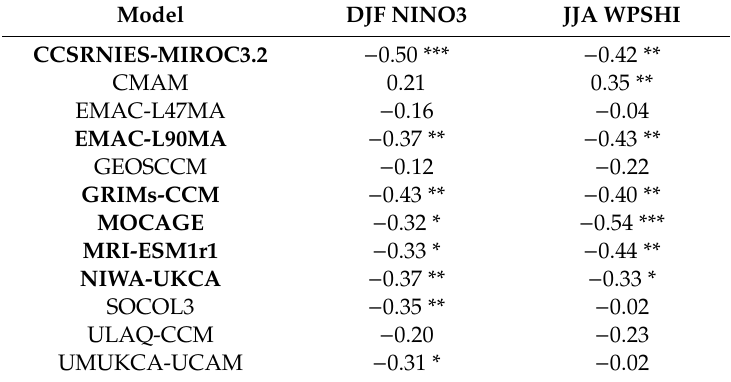
Figure 10. The regressed fields of ( a ) DJF, ( b ) MAM, and ( c ) JJA sea surface temperature (SST) anomalies (shaded; °C) and 850 hPa geopotential height anomalies (contour; m). Black dots indicate statistical significance at the 90% confidence level for SST anomalies based on a Student’s t-test. Table 3. The linear correlation coefficients between PC2 time series, DJF NINO3, and JJA WPSH indices for each of CCMI models. *, **, and *** indicate statistical significance at the 90%, 95%, and 99% confidence levels through a Student’s t-test, respectively. Models statistically significant for both indices are shown in